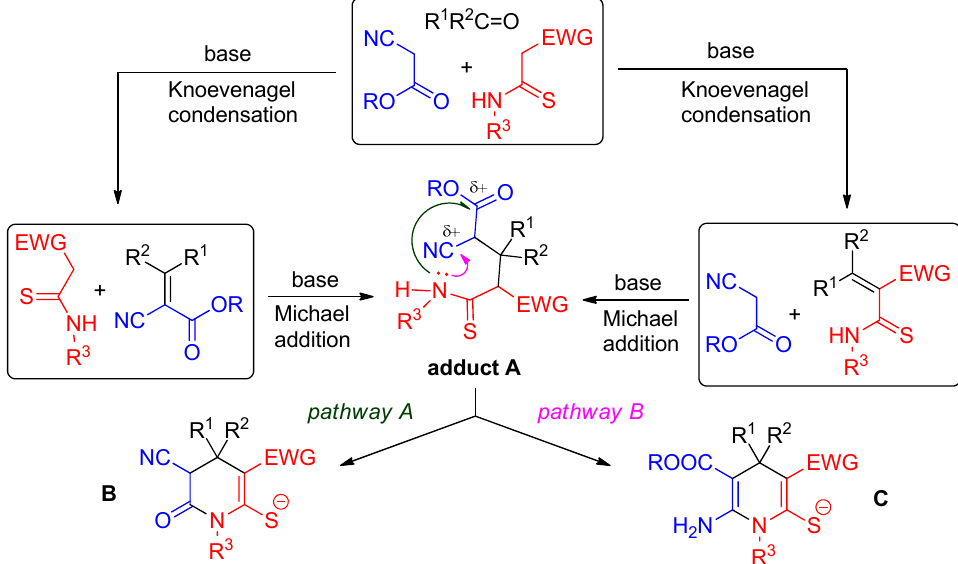
Scheme 2. Two possible directions for heterocyclization reactions of active methylene thioamides with cyanoacetic esters or